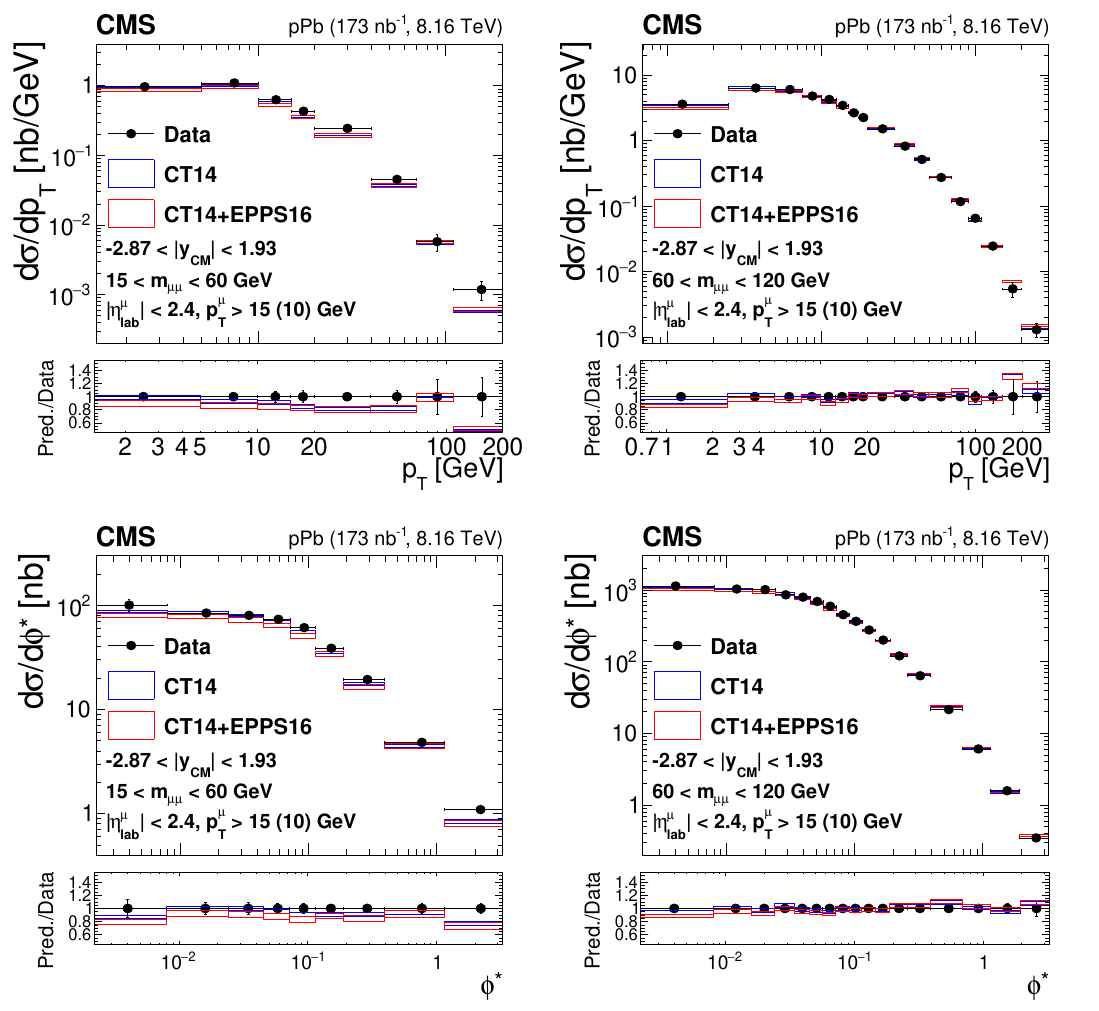
Figure 6 . Differential fiducial cross sections (without the acceptance correction) for the DY process measured in the muon channel, as functions of p (upper row) and φ ∗ (lower row), for 15 < m < T mm 60 GeV (left) and 60 < m and φ ∗ measurements starts < 120 GeV (right). The first bin of the p T mm at 0. The error bars on the data represent the quadratic sum of the statistical and systematic uncer- tainties. Theory predictions from the powheg NLO generator are also shown, using CT14 (blue) or CT14+EPPS16 (red). The boxes show the 68% confidence level (n)PDF uncertainty on these predic- tions. The ratios of predictions over data are shown in the lower panels, where the data and (n)PDF uncertainties are shown separately, as error bars around one and as coloured boxes,